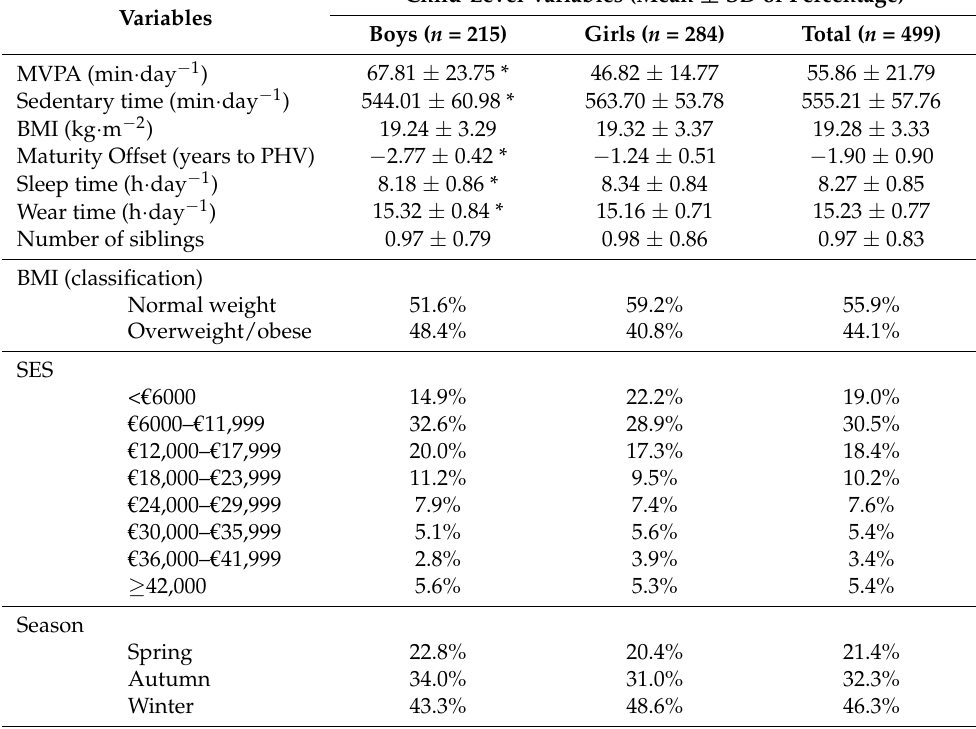
Table 1. Descriptive statistics for variables at the child level (level 1). MVPA,